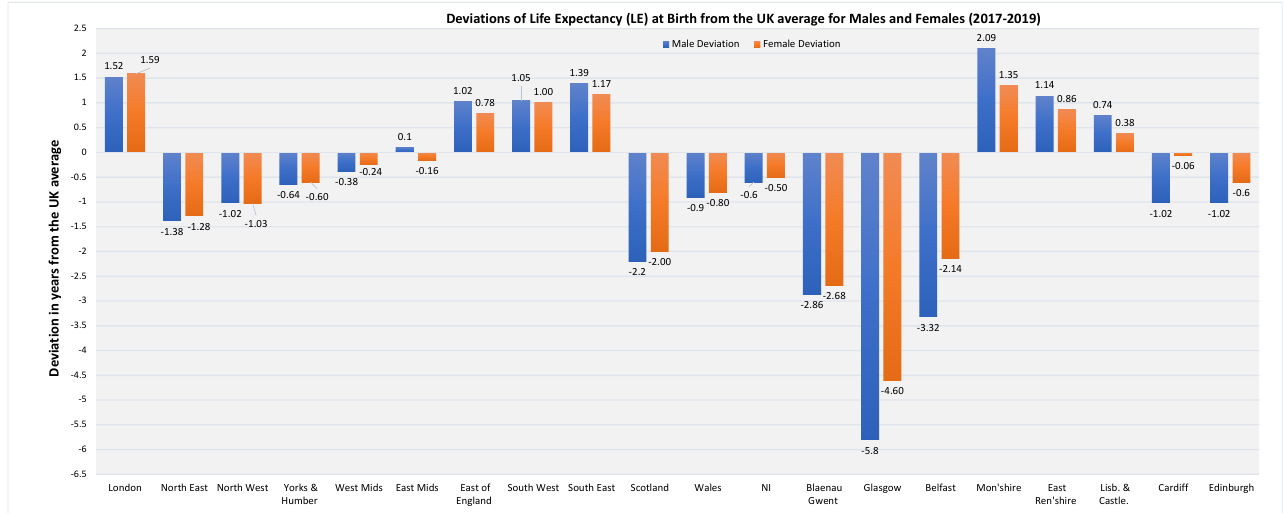
Figure 2. Deviations from the UK average life expectancy (LE) for selected UK regions and districts.